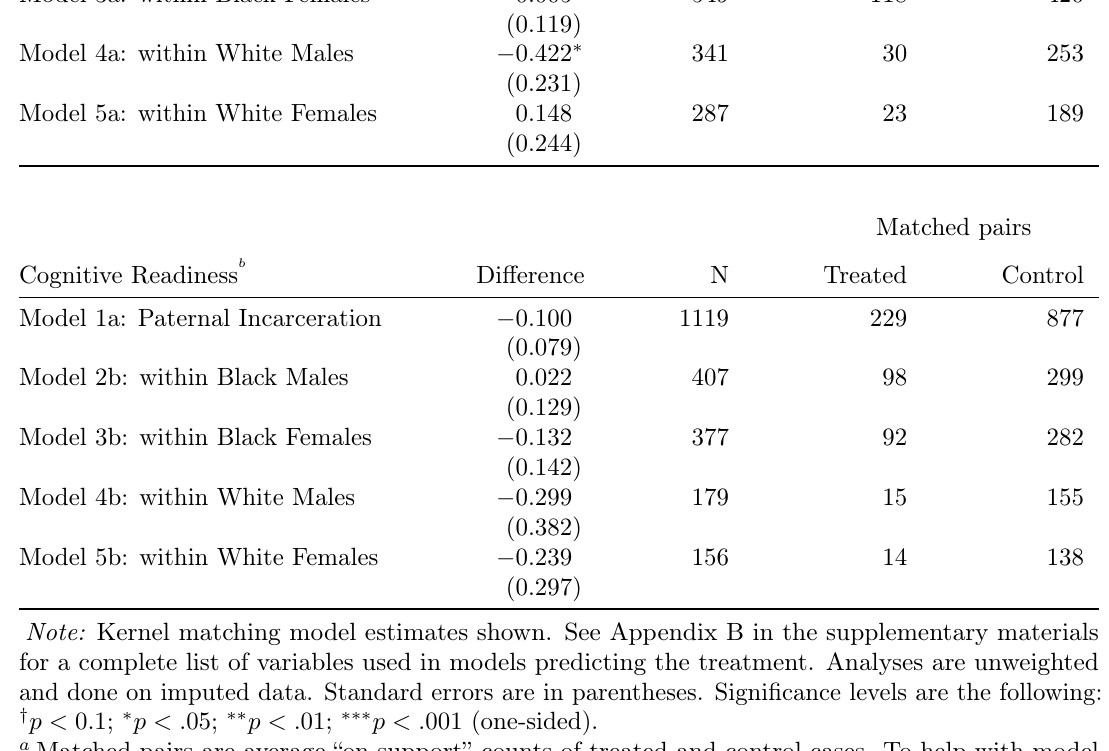
Table 2: Results from Propensity Score Matching Predicting both types of School Readiness at Age Five Non-Cognitive Readiness a